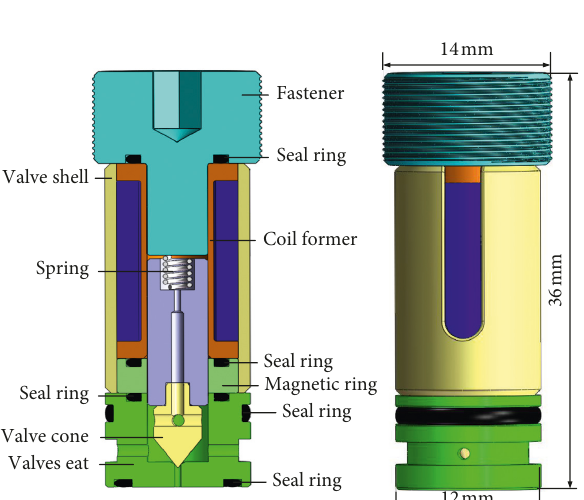
Figure 3: Mesh model of the traditional valve.